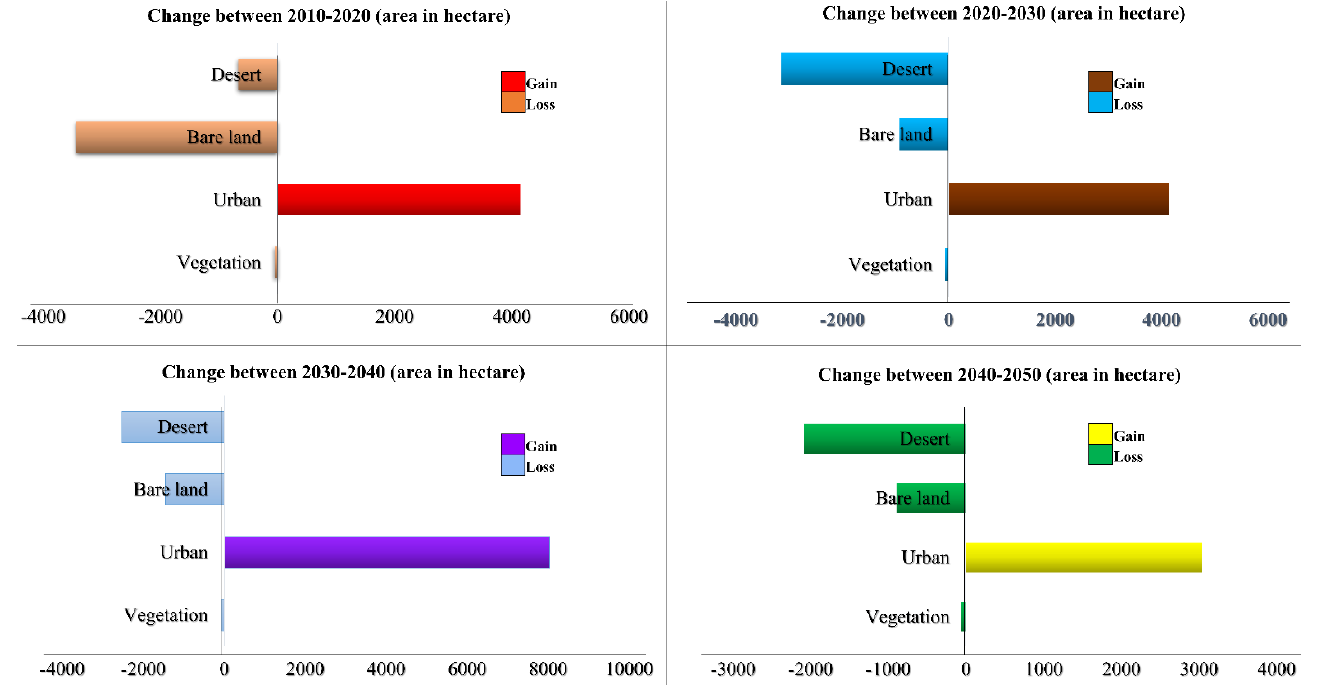
Figure 7. Simulated LULC scenarios for 2030 ( A ), 2040 ( B ), and 2050 ( C ) in the study area.